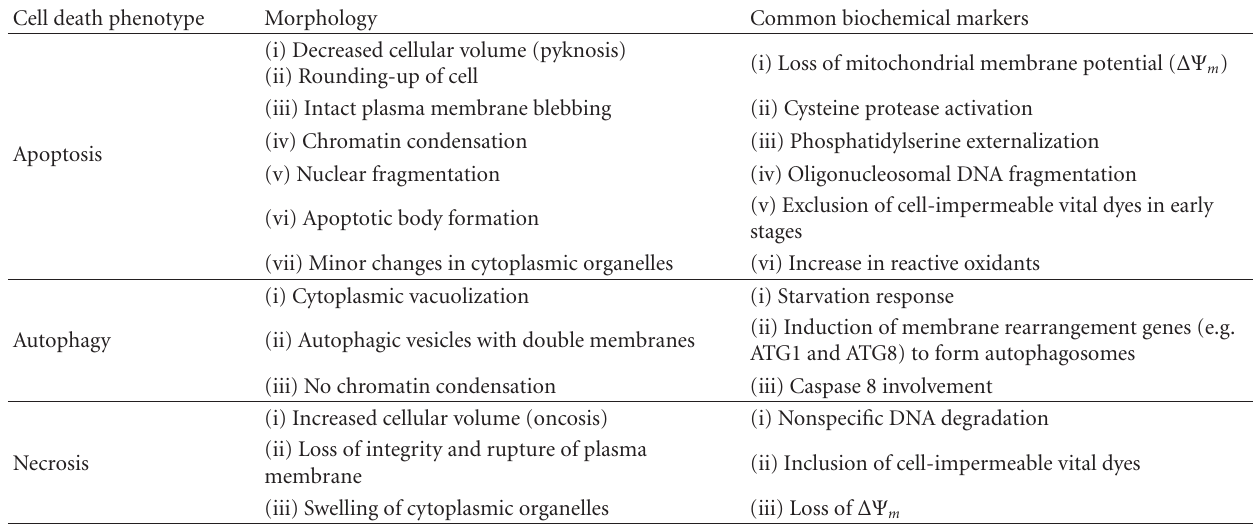
Cell death phenotype Morphology Common biochemical